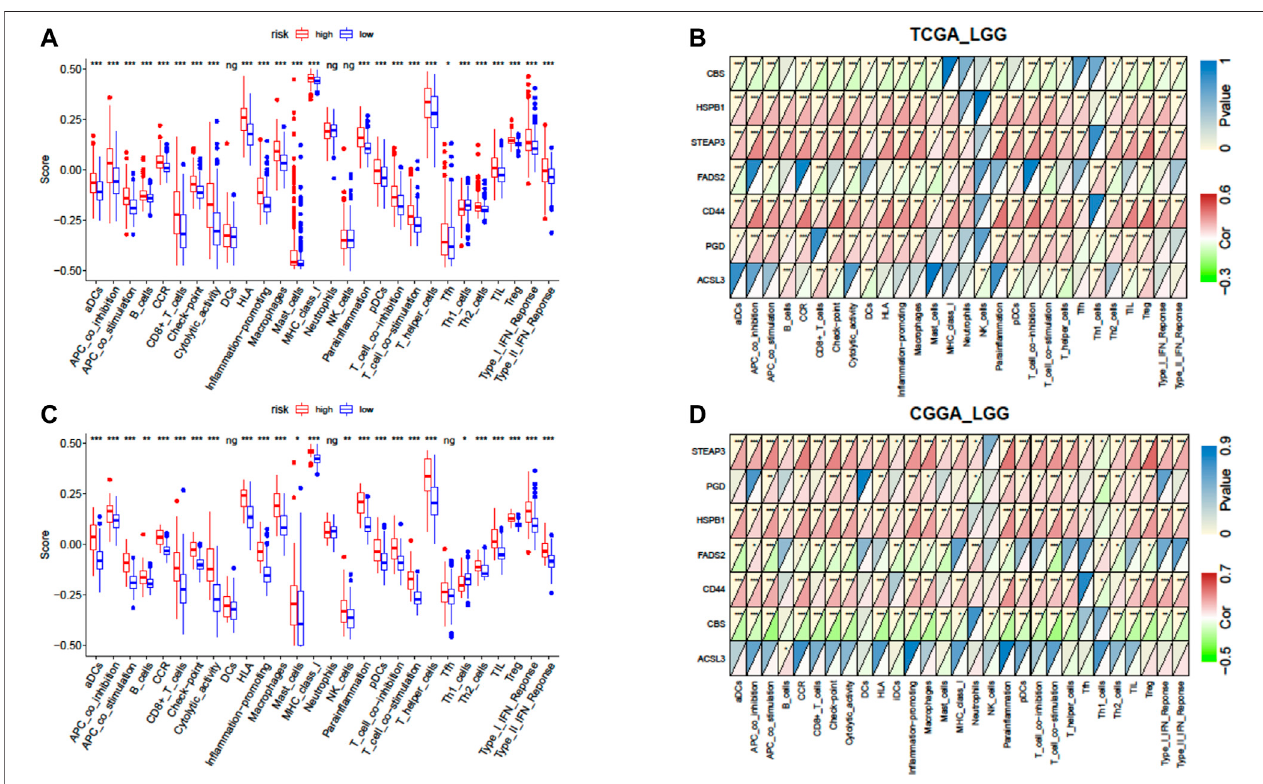
FIGURE 8 | Correlation of the risk score with in fi ltrative immune cells. (A) Comparison of the ssGSEA scores between different risk groups in TCGA cohort. (B) Correlations between ssGSEA scores and risk scores in TCGA cohort. (C) Comparison of the ssGSEA scores between different risk groups in the CGGA cohort. (D) Correlations between ssGSEA scores and risk scores in the CGGA cohort. P values are shown as follows: ns, not signi fi cant; * p < 0.05; ** p < 0.01; *** p < 0.001.